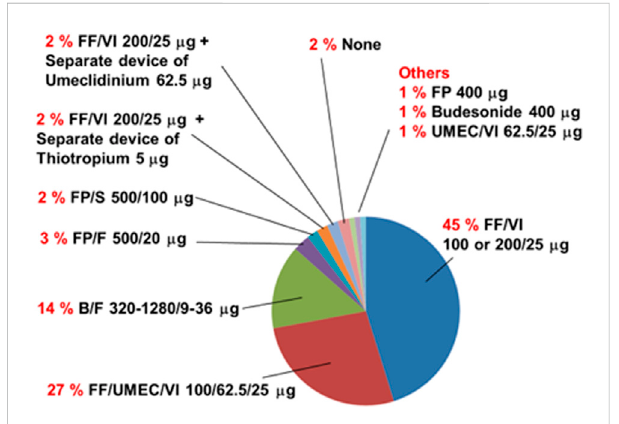
FIGURE 2 Previous inhalation drugs used before the use of the single inhaler fl uticasone furoate/umeclidinium/vilanterol 200/62.5/25 μ g by asthma patients (n = 104). Two percent (n = 2) of subjects with asthma had not used inhalation drugs for more than 3 months before the use of this combined drug (None). B/F, budesonide with formoterol fumarate; FF/UMEC/VI, fl uticasone furoate with umeclidinium and vilanterol; FF/VI, fl uticasone furoate with vilanterol; FP, fl uticasone propionate; FP/F, fl uticasone propionate with formoterol fumarate; FP/S, fl uticasone propionate with salmeterol xinofoate;UMEC/VI,umeclidiniumwithvilanterol.Drugdosagevalues represent daily doses.